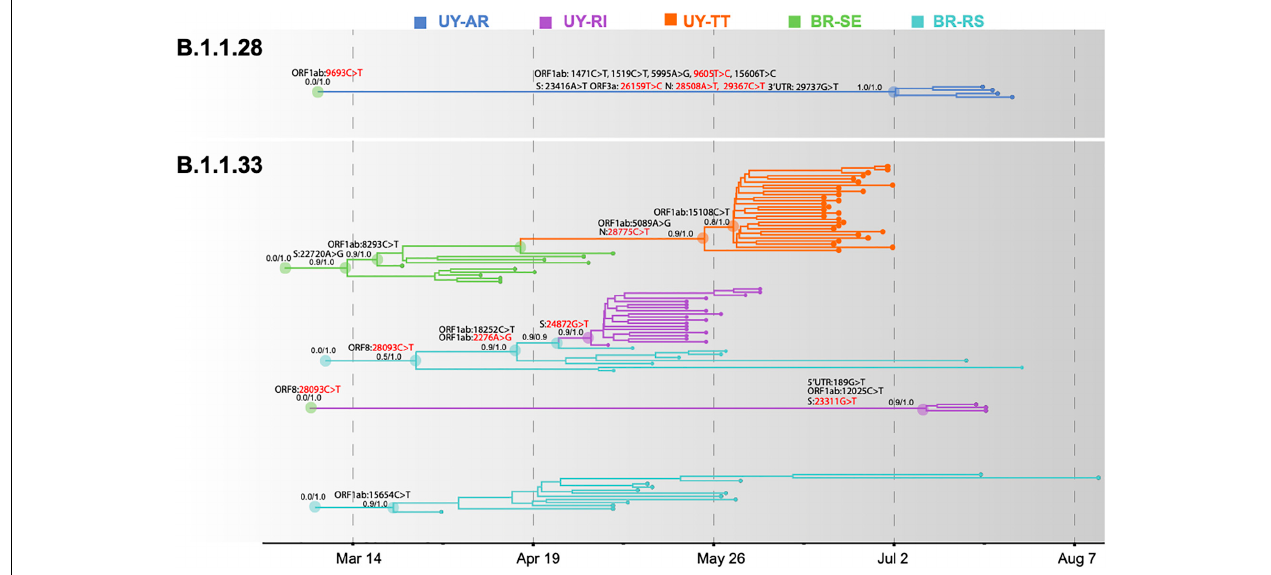
FIGURE 4 | Spatiotemporal dissemination of SARS-CoV-2 Uruguayan–Brazilian clades. Uruguayan–Brazilian clades inferred on the time-scaled Bayesian phylogeographic MCC tree ( Supplementary Figures 3, 4 ) plotted independently. Branches are colored according to the most probable location state of their descendant nodes as indicated at the legend. Posterior probability/posterior state probability support values are indicated at key nodes. Synonymous (black) and non-synonymous (red) substitutions fixed at ancestral nodes are